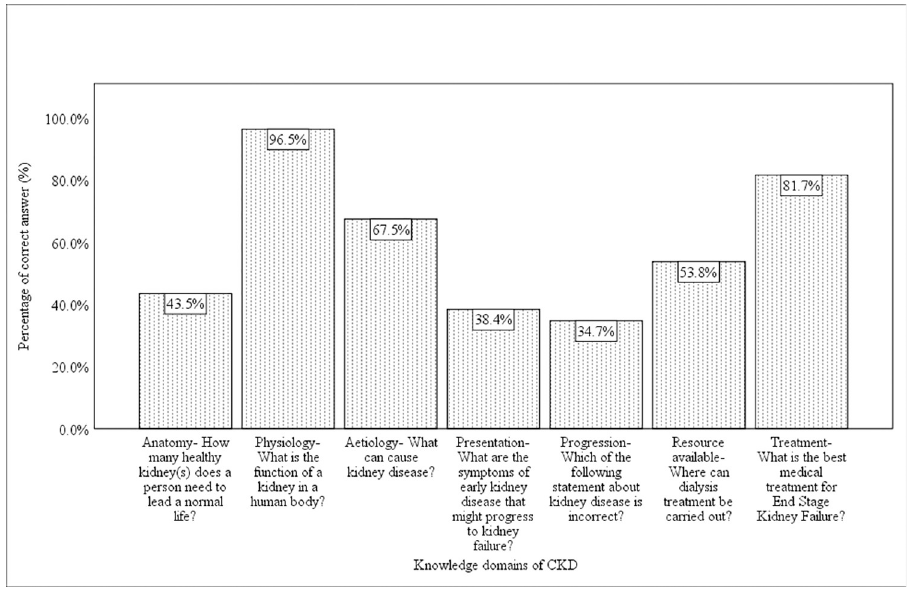
Fig 1. Percentage of correct answers by knowledge domains of